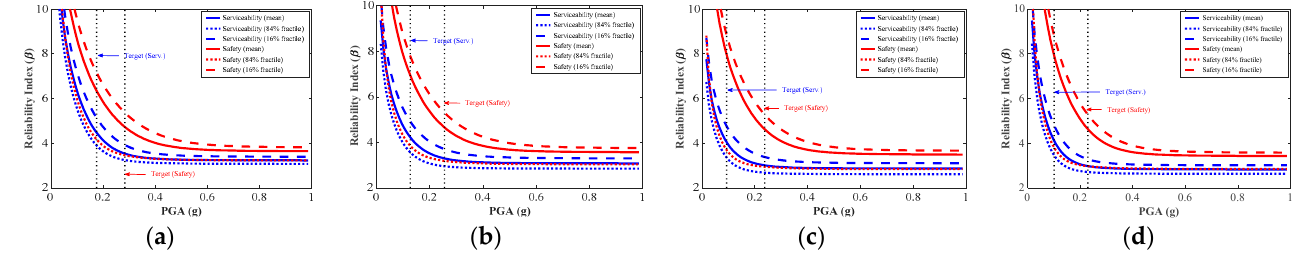
Table 3. High confidence of low probability of failure (HCLPF) point from the CGD response of each year. Aging ‐ Effect